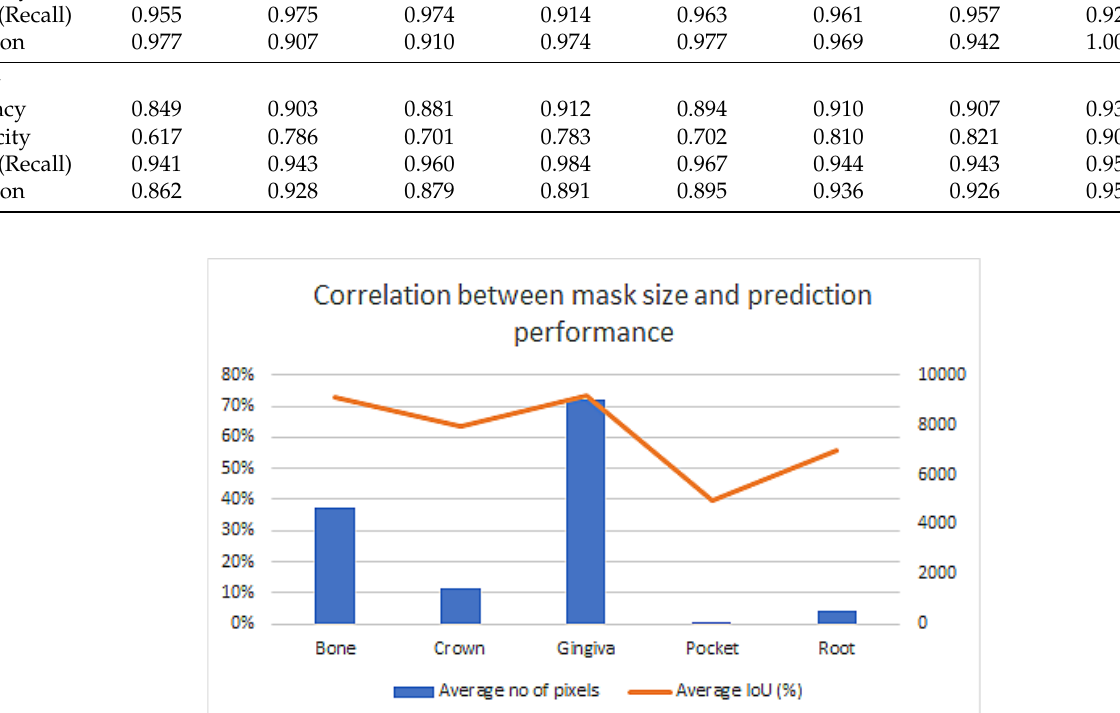
Figure 17. The correlation between the number of element presence in dataset and the prediction accuracy. 4. Discussion As far as we know, this is the first time when all the necessary anatomical elements for periodontal diagnosis were automatically identified in human ultrasound images. Pre- vious studies focused on a single [23] or several elements [24], but not all. This was the biggest challenge because manual or semi-automatic segmentation to prepare the datasets for training is time consuming and needs a lot of experience from the operator. Moreover, the periodontal US images may contain up to five elements: bone, crown, gingiva, perio- dontal pocket, and root. There are large variations of characteristics in these elements, especially in terms of their size and occurrence. The periodontal pocket was present only in about 10% of the acquired images in this study, because almost half of the images were from inter-dental spaces where neither the crown, the root, nor the periodontal pocket were present. Another reason is that if the gingival sulcus is very thin, without having sulcular secretion it may not be visible in the original ultrasound image. At extremes, in terms of size, gingiva can be tens of times larger than a pocket. Fur- thermore, gingiva was present in all images, while the pocket was present only in only 10% of the images. These elements make the learning process very difficult.